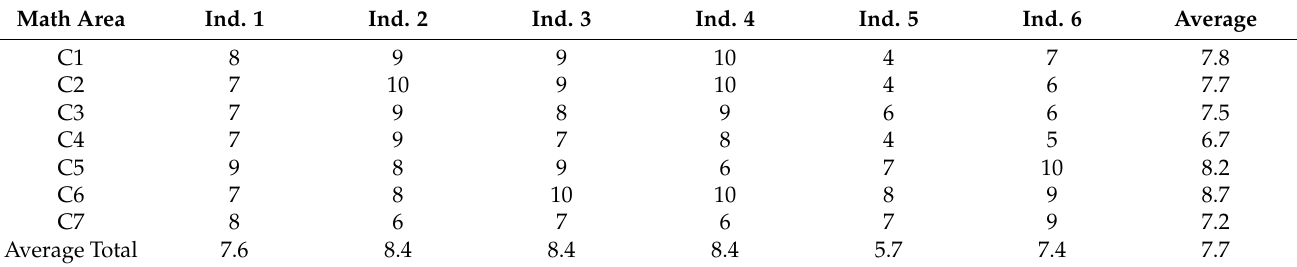
Table 3. Ranges and averages of the evaluation of the teaching of the numbers N, using a teaching model through an AI recognition